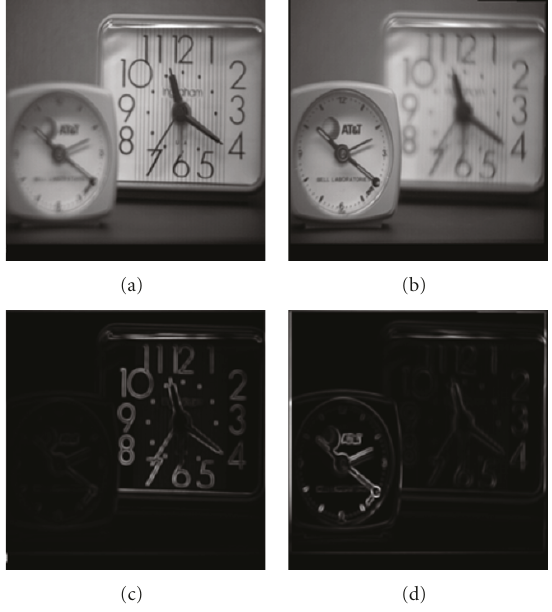
Figure 8: (a) and (b) Original “clock” source images, respective weights (c) c · λ and (d) c · (1 − λ ) used for image fusion quality